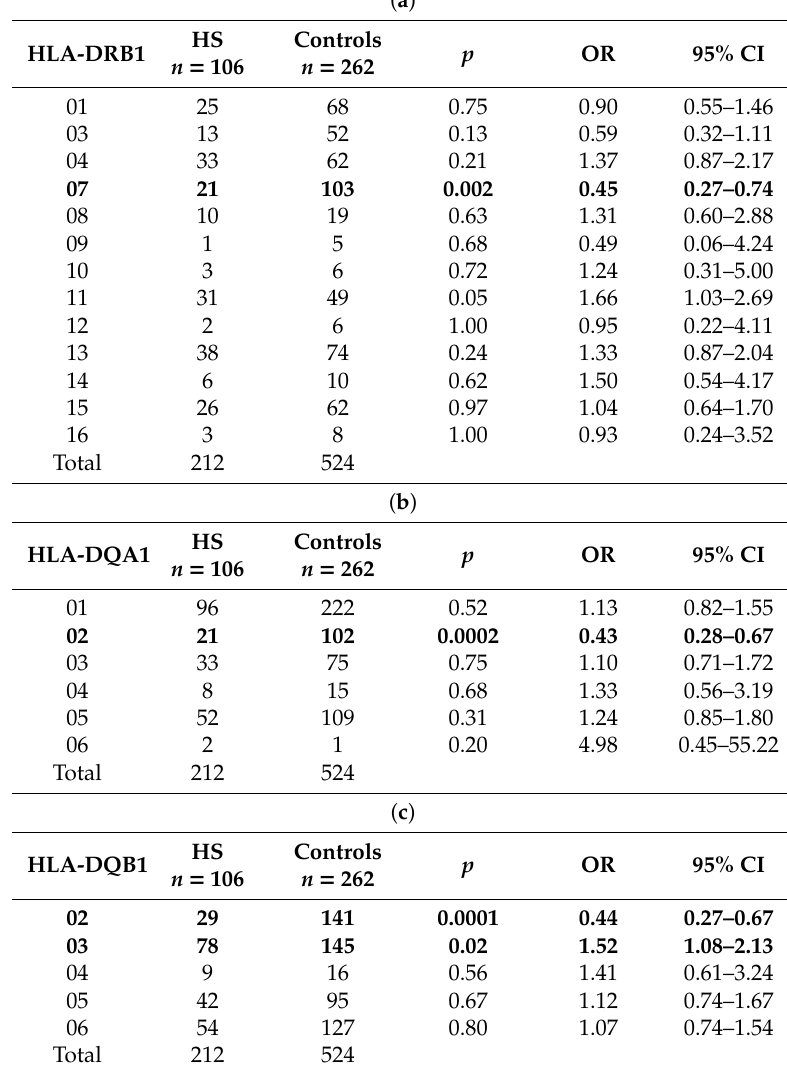
Table 2. HLA-DRB1 (a), -DQA1 (b), and -DQB1 (c) allele frequencies in HS patients and healthy